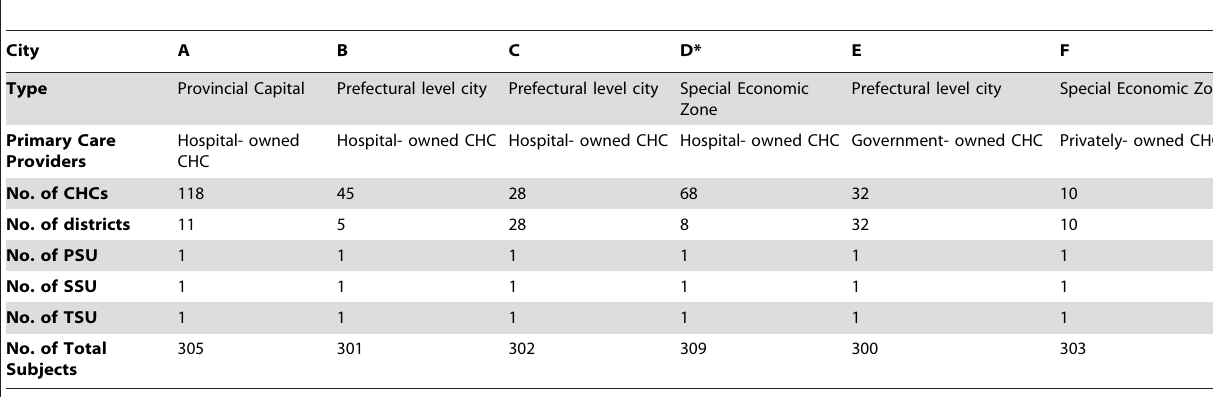
Table 1. The characteristics of the six cities under